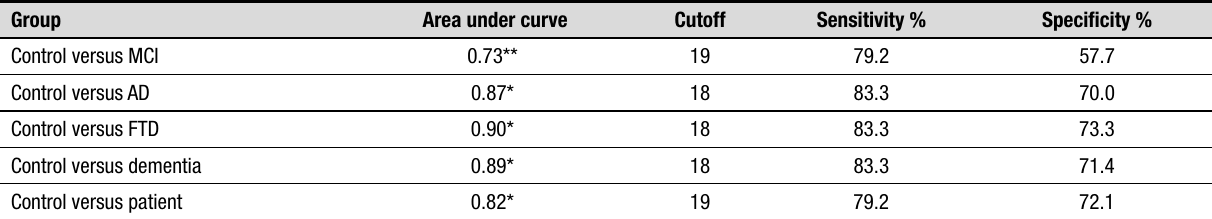
Table 4. Cutoffs for TOP-J/Br.